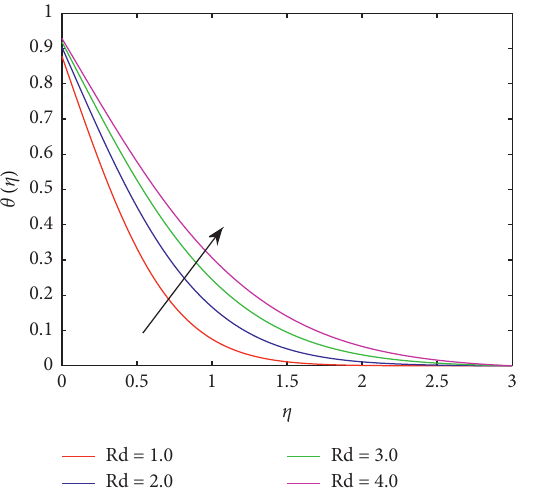
Figure 9: Variation due to λ in θ ( η ) .